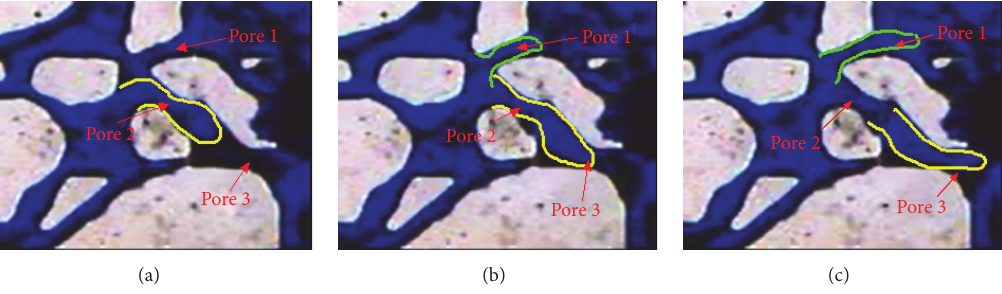
Figure 5: Water flowing diversion by weak gel.